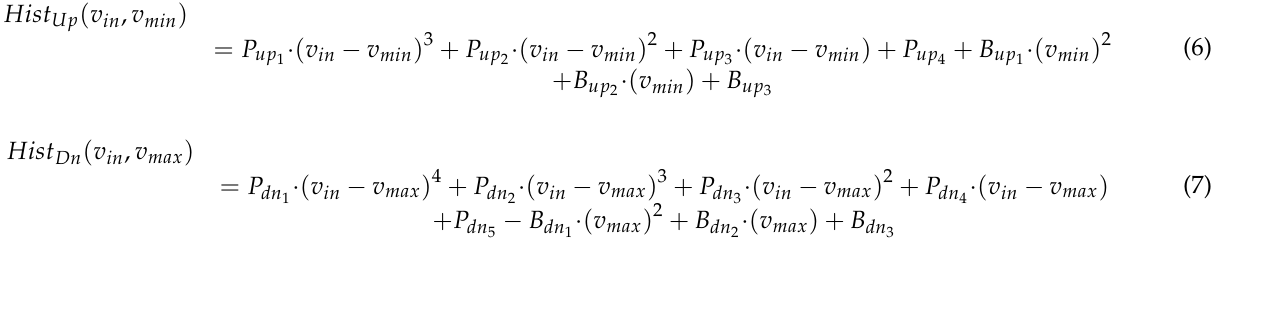
Figure 6. Classical hysteresis curve of PEMs [62].